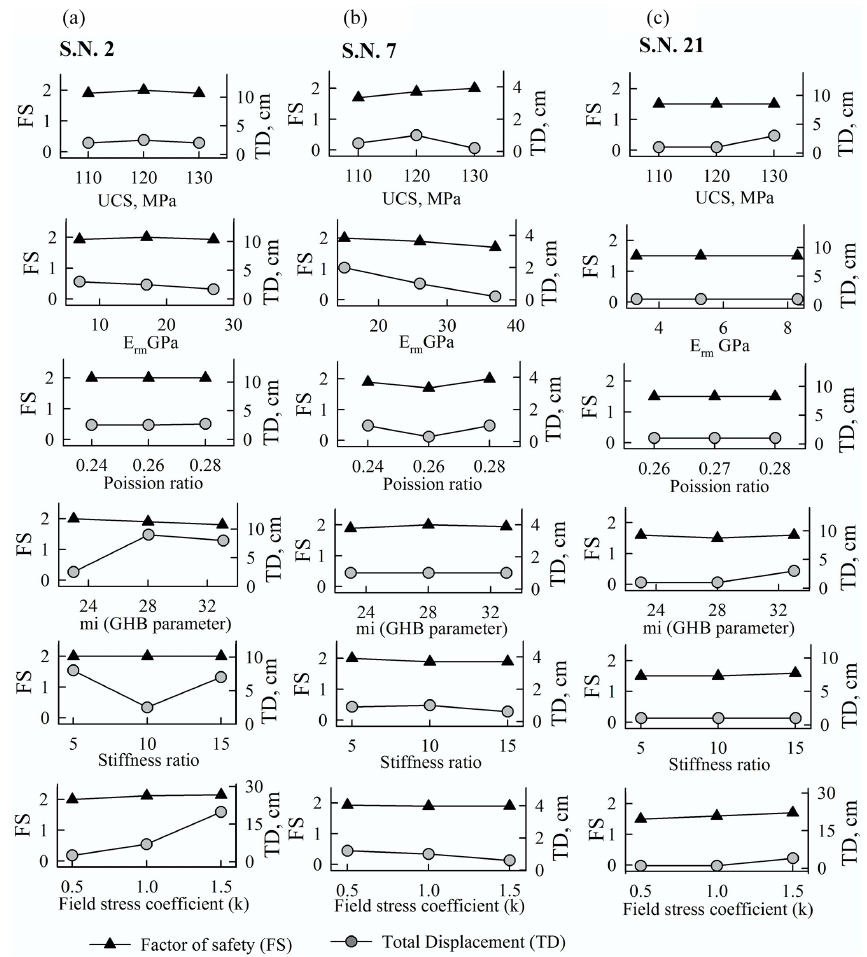
Figure 7. Parametric analysis of rockfalls and rock avalanches: (a) Tirung Khad (no. 2), (b) Baren Dogri (no. 7), and (c) Chagaon_II (no.